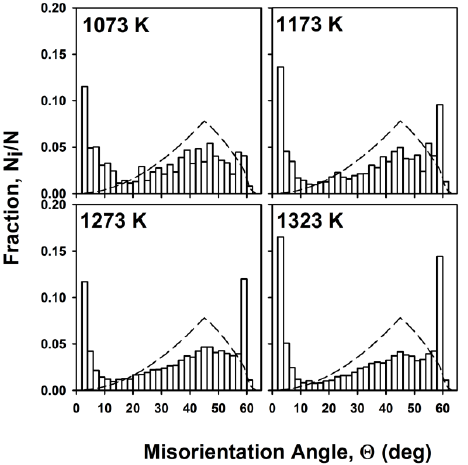
Figure 5. Distributions of the DRX grain boundary misorientations developed in the high-nitrogen austenitic stainless steel during compression to a strain of 1.2 at the indicated temperatures and a strain rate of 10 −3 s −1 . The dashed lines indicate random (Mackenzie) distribution.